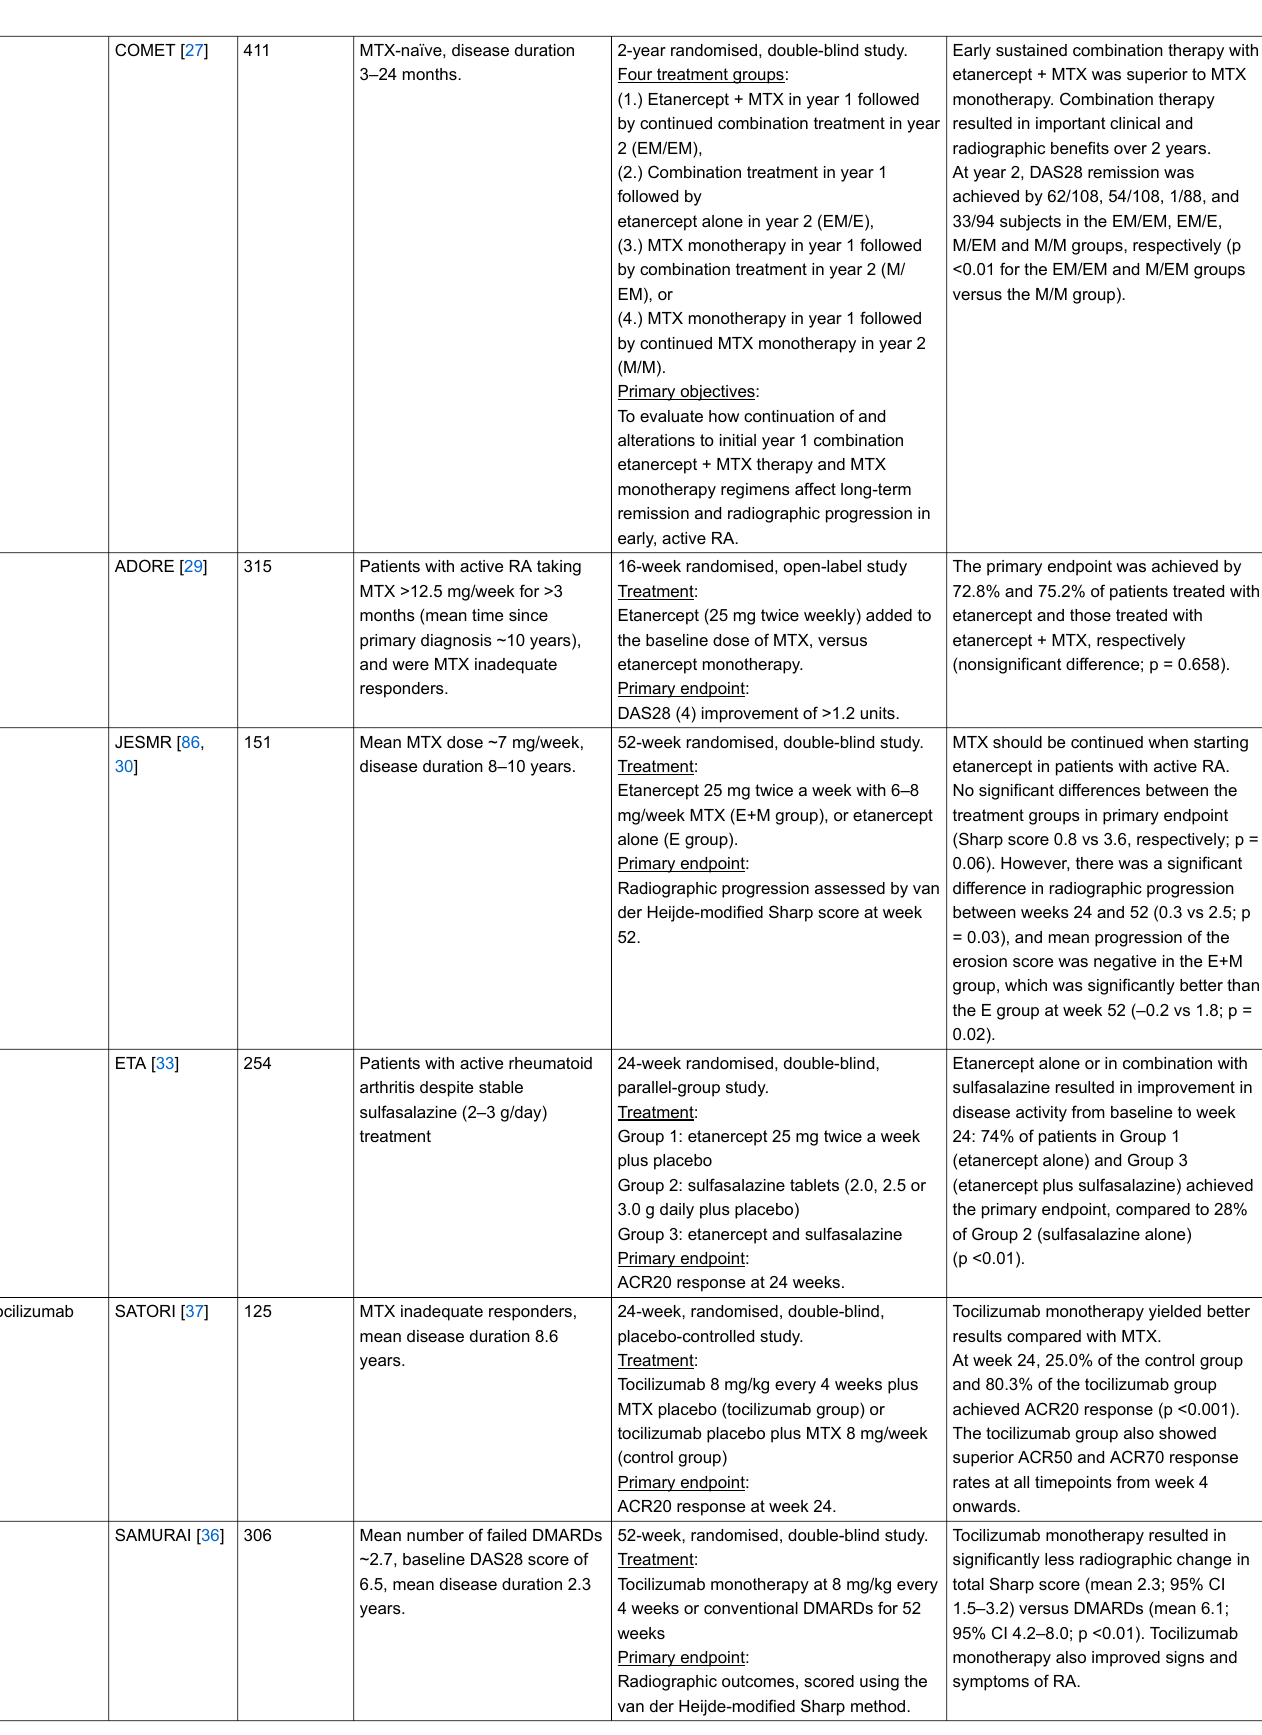
2-year randomised, double-blind study. Four treatment groups: